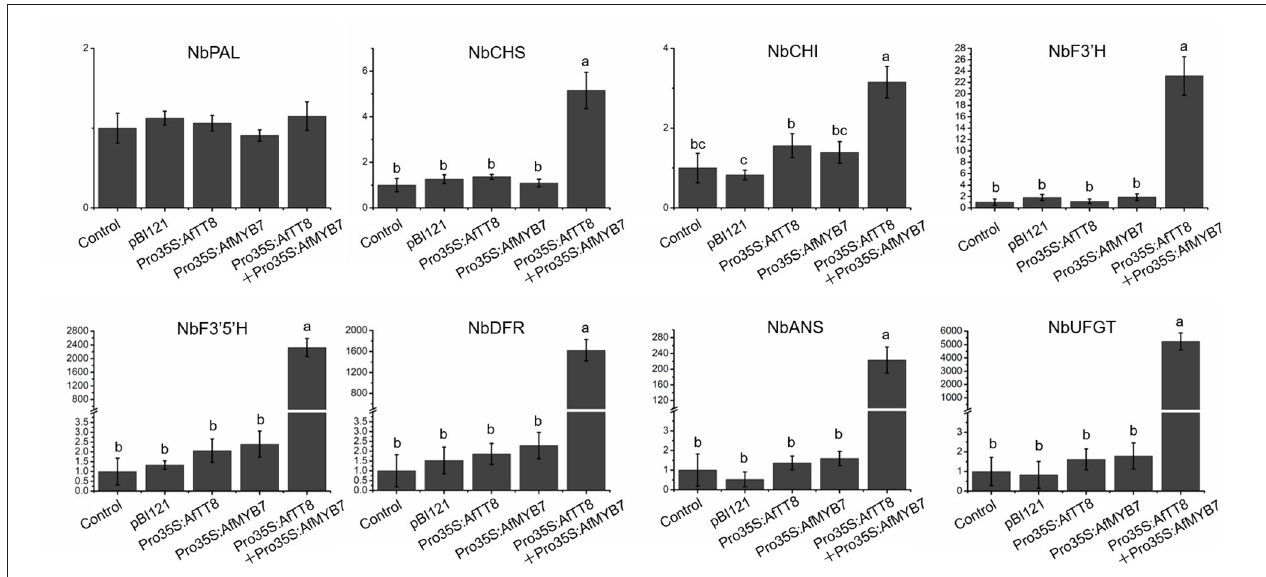
FIGURE 6 | Expression analysis of anthocyanin biosynthetic genes in tobacco leaves infiltrated by Agrobacterium tumefaciens with different expression constructs. The longitudinal axis represents relative gene expression normalized to NbActin . Triplicate biological replicates were conducted and different letters represent significance at p <